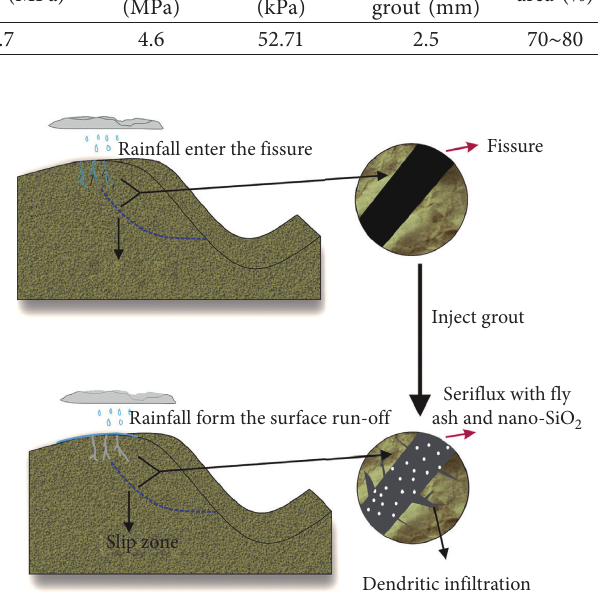
Figure 14: Schematic diagram of fissures in Lvliang Airport: (a) before grouting; (b) after